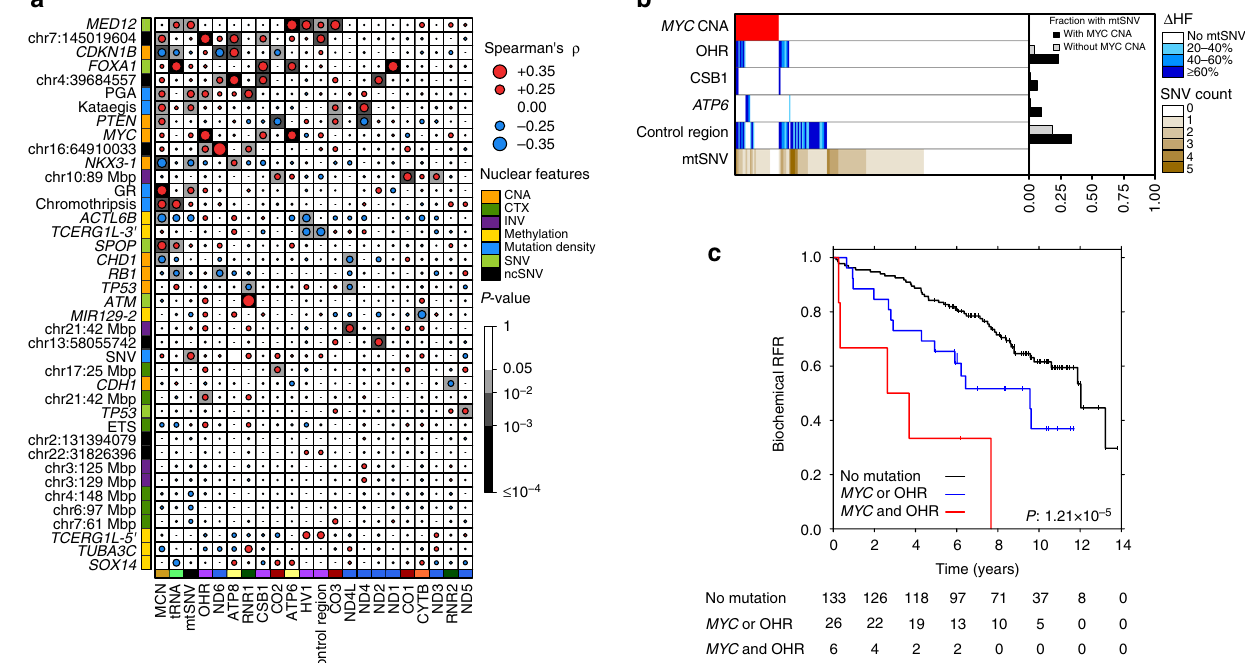
Fig. 3 Associations between mitochondrial and nuclear genome mutations. a Correlations of mitochondrial features with nuclear genome features. The size and color of the dot represents the Spearman correlation and the background shading represents the P -value. Nuclear features: SNVs, CTXs, INVs, kataegis data available for 172 patients; Chromothripsis: n = 159; CNAs: MYC, NKX3-1 ( n = 203); CDH1, CDKN1B, CHD1, PTEN, RB1, TP53 ( n = 194); Methylation: n = 104. Mitochondrial features: 216 patients. b Mutations in OHR are associated with CNAs in MYC. Heatmap showing those patients with CNA gains ( red ) in MYC and those with mtSNVs in OHR, CSB1, the control region and ATP6, mtSNV color represents the Δ HF. Since CSB1 is a subregion within OHR, mutations in CSB1 are also considered as OHR mtSNVs, similarly, mtSNVs in OHR are also within the control region ( n = 203). The bar plot on the right shows the fraction of patients with or without a MYC CNA that have a speci fi c mtSNV. c Kaplan – Meier plot of 165 patients with OHR and MYC mutations. Patients were grouped according to whether they had neither MYC CNAs nor OHR SNVs ( black line ), a MYC CNA or an OHR mtSNV ( blue ) or had both ( red line ). The group that had a CNA gain in MYC and an mtSNV in the OHR region had signi fi cantly worse outcomes than those without the